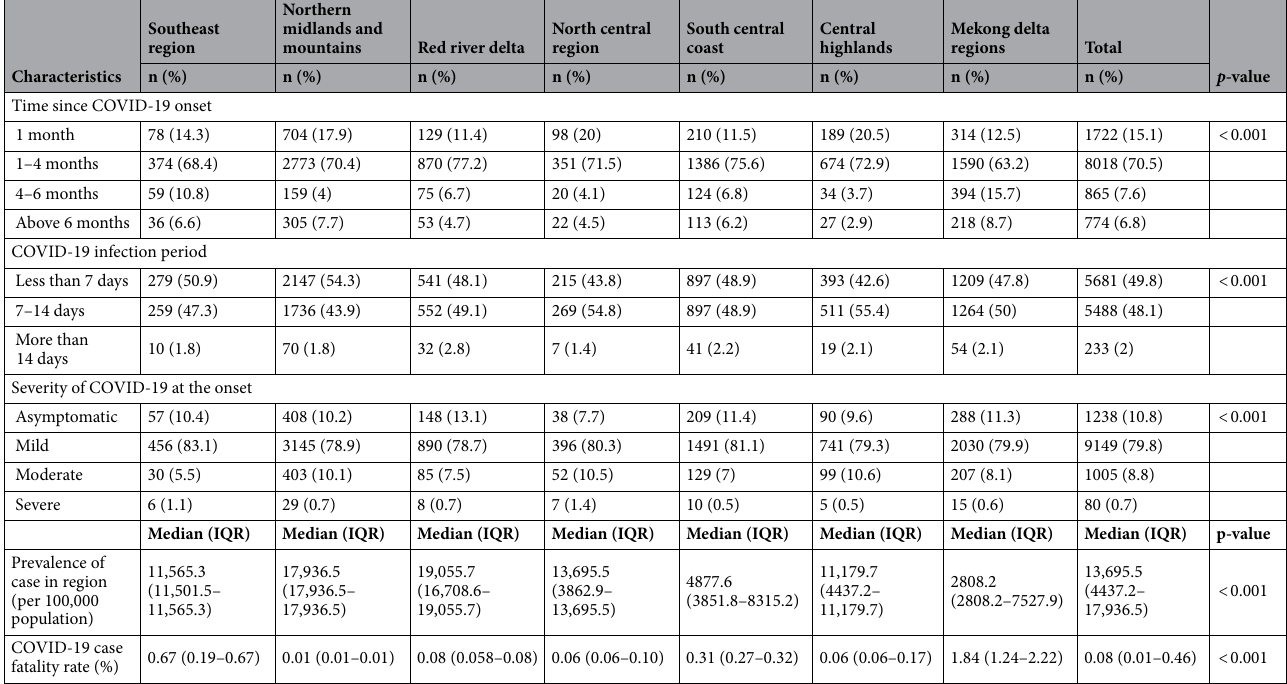
Table 2. Characteristics of participants when infected with COVID-19 by province.